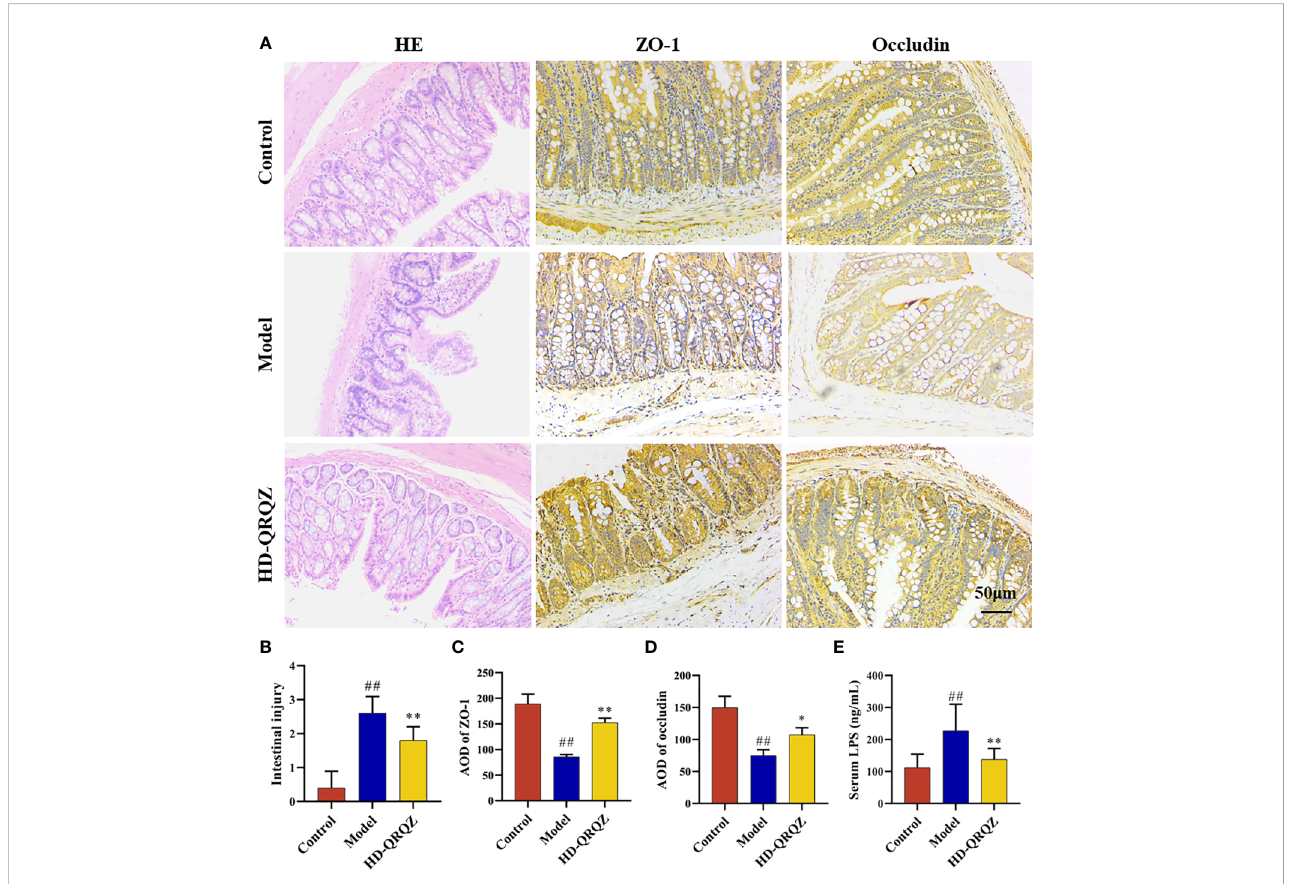
FIGURE 4 QRQZ improved the gut barrier. (A) HE staining of colon from each group and immunohistochemistry showed expression of ZO-1 and Occludin in colon. (200×) (B) Histological assessment of intestinal injury. (C, D) AOD of ZO-1 and Occludin. (E) Serum LPS levels of each group. Control, Model and HD-QRQZ (n = 6 per group) groups. Data are presented as the mean ± standard deviation. ## P < 0.01 as compared to the Control group; * P < 0.05 as compared to the Model group; ** P < 0.01 as compared to the Model